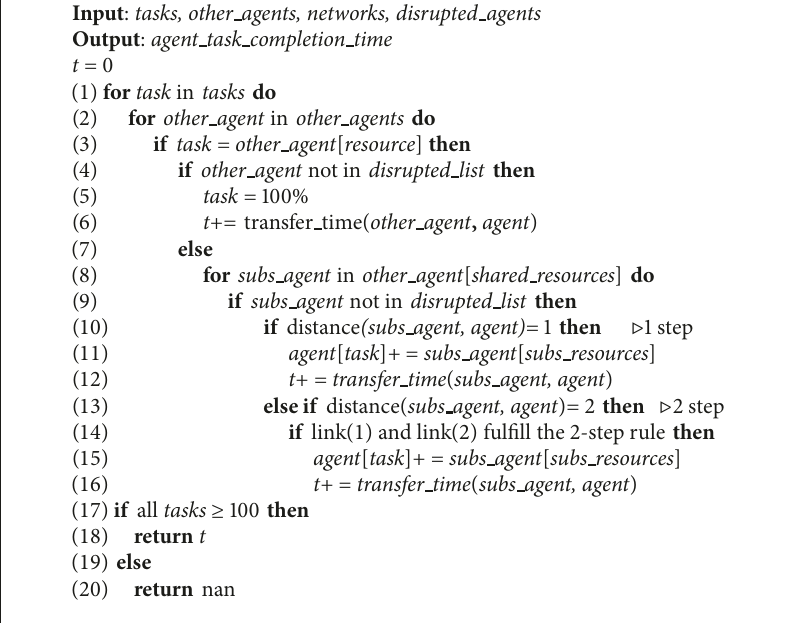
Algorithm 1: Task completion and resource